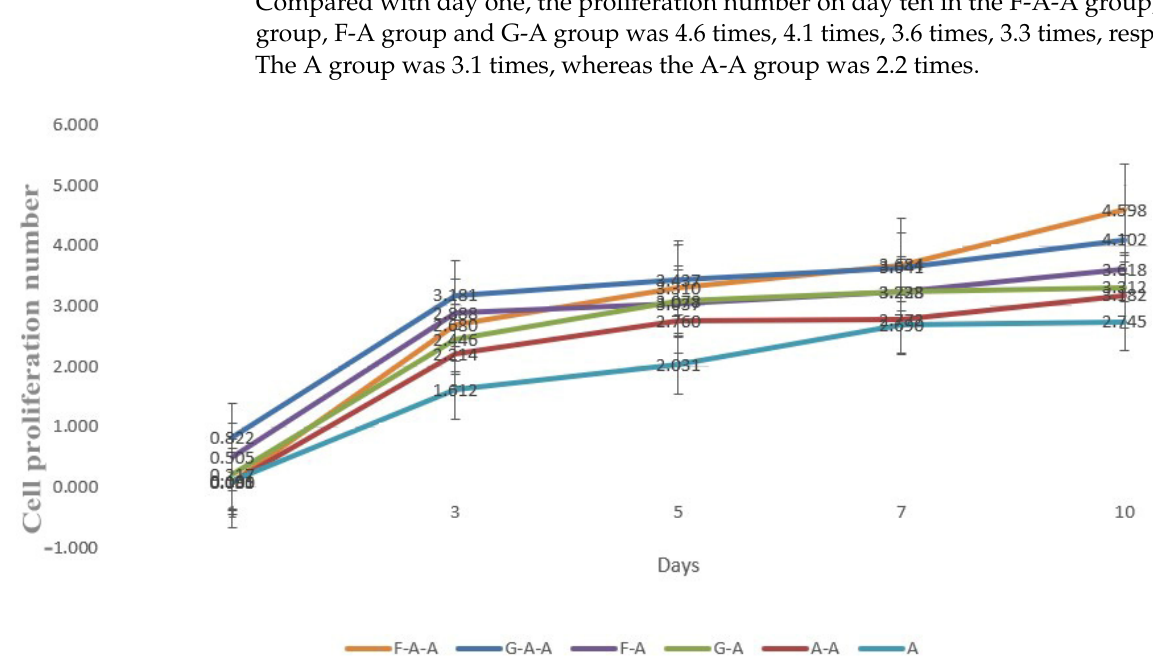
Figure 8. Cell proliferation states in different hydrogels.